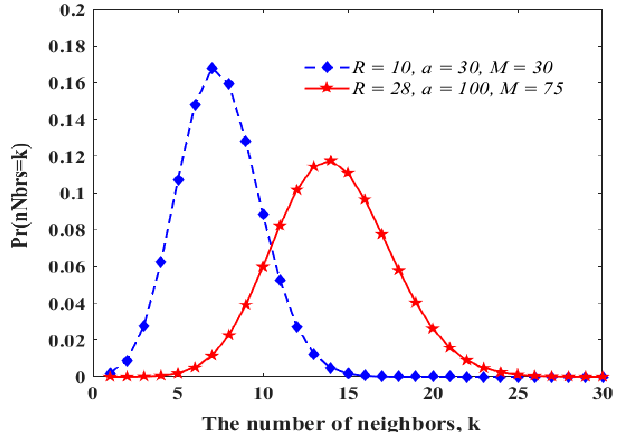
Figure 6. Distribution of node degrees. Sensors 2019 , 19 , x FOR PEER REVIEW